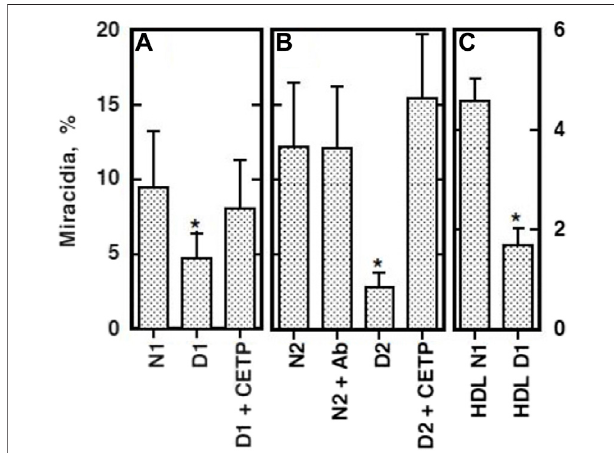
FIGURE 5 | Embryonation of the eggs of S. japonicum in vitro in the presence of HDL from patients with CETP de fi ciency (Okumura-Noji et al., 2001). Egg embryonation was estimated when an adult pair of the parasite was cultured for 8 and 10 days (A – C) , respectively). The culture media contained 10% normal human sera (N1 and N2) and CETP-de fi cient human sera (D1 and D2). Patients with CETP de fi ciency were both identi fi ed as intron 14 splicing defect. Ab indicates the presence of anti-CETP inhibitory monoclonalantibody(IgG).CETPindicatespresenceofpuri fi edhumanCETP. HDL N1 and HDL D1 indicate the HDL isolated from normal human plasma (N1) or the CETP-de fi cient plasma (D1). Each panel represents an independent experiment, in which the data points are the average ± SE of the four (A, C) andeight (B) measurements.* p < 0.05 differentfrom N.* p =0.059 between HDL N1 and HDL D1.